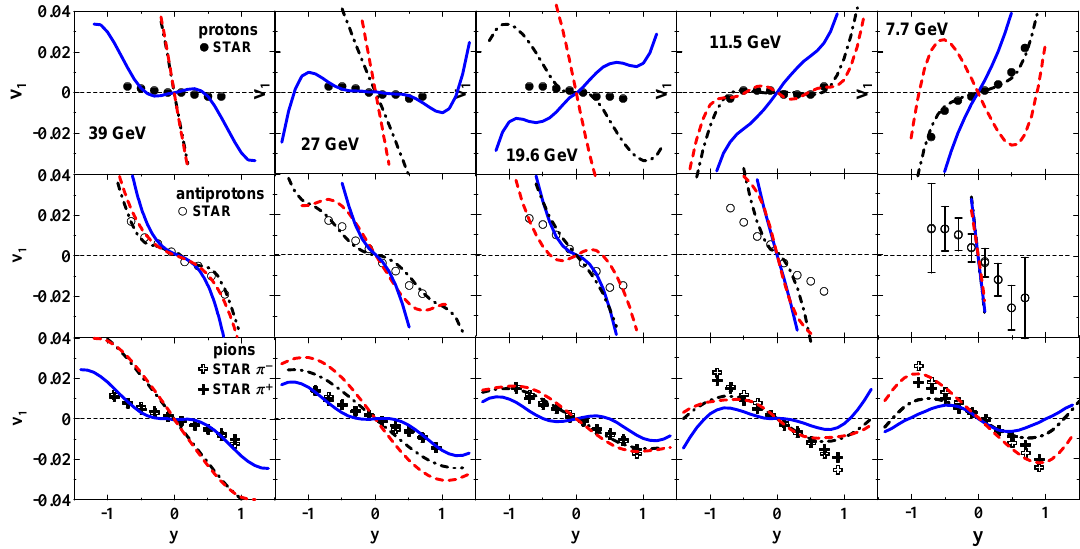
Figure 2. The directed flow v 1 ( y ) for protons, antiprotons and pions from mid-central ( b = 6 fm) Au+Au collisions at √ s NN = 7.7–39 GeV calculated with different EoSs. Experimental data are